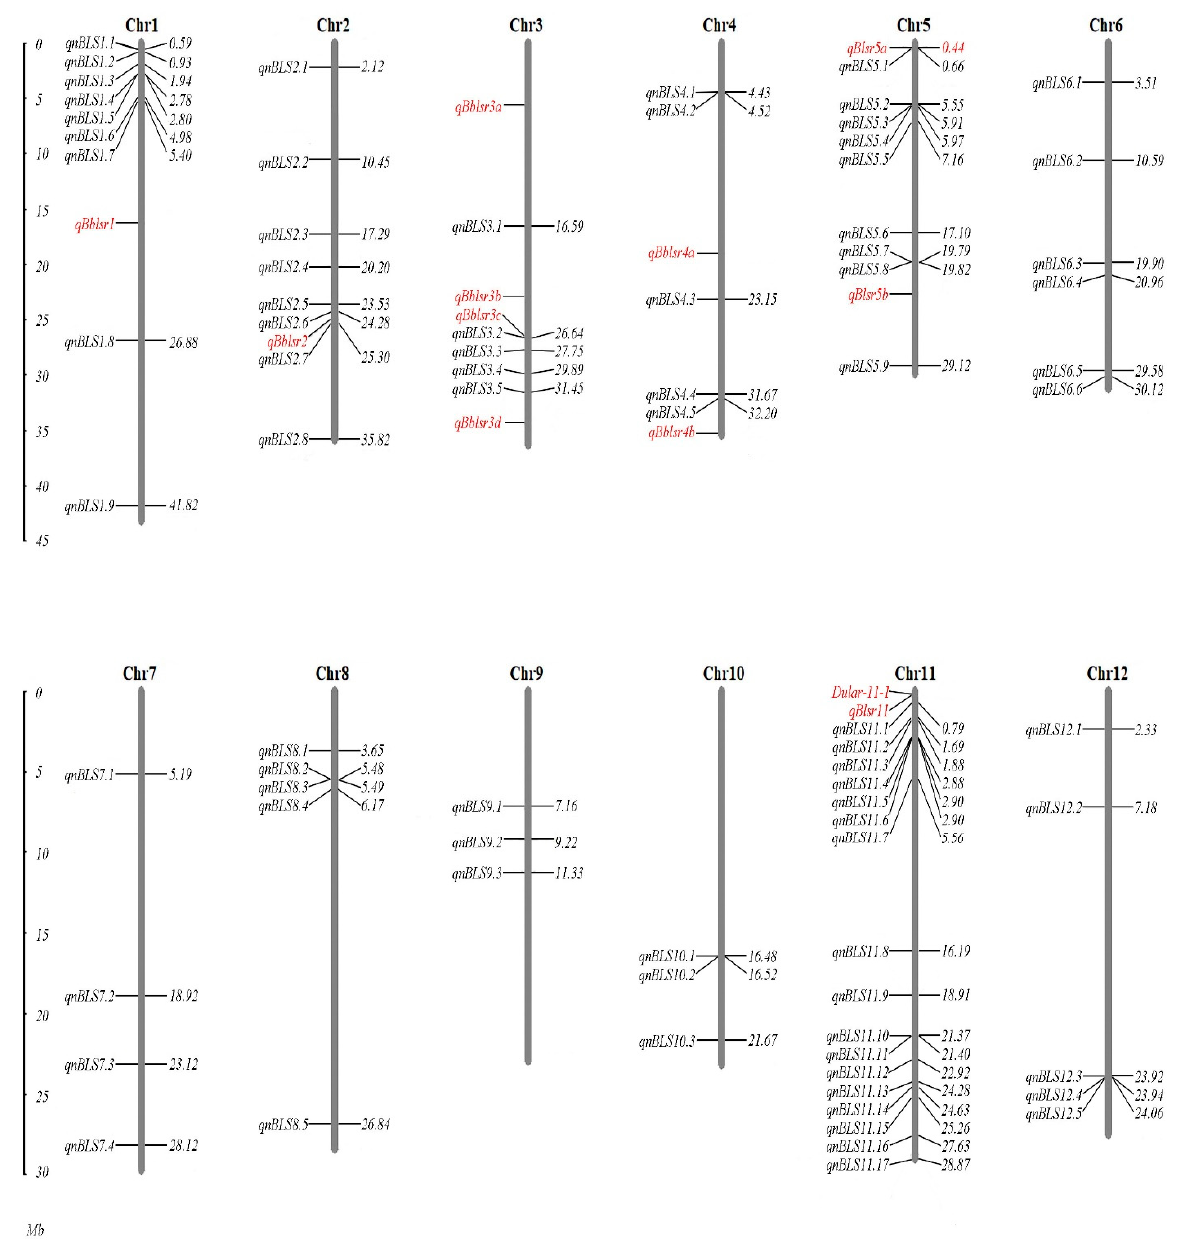
Figure 4. Distribution of 79 QTNs detected in this study, as well as reported QTLs/genes related to BLS resistance in the rice genome. For each chromosome, the names and physical positions (Mb) of QTNs/QTLs are shown on the left and the right, respectively. The QTNs detected in this study are shown in black, while the reported QTLs and genes are shown in red.